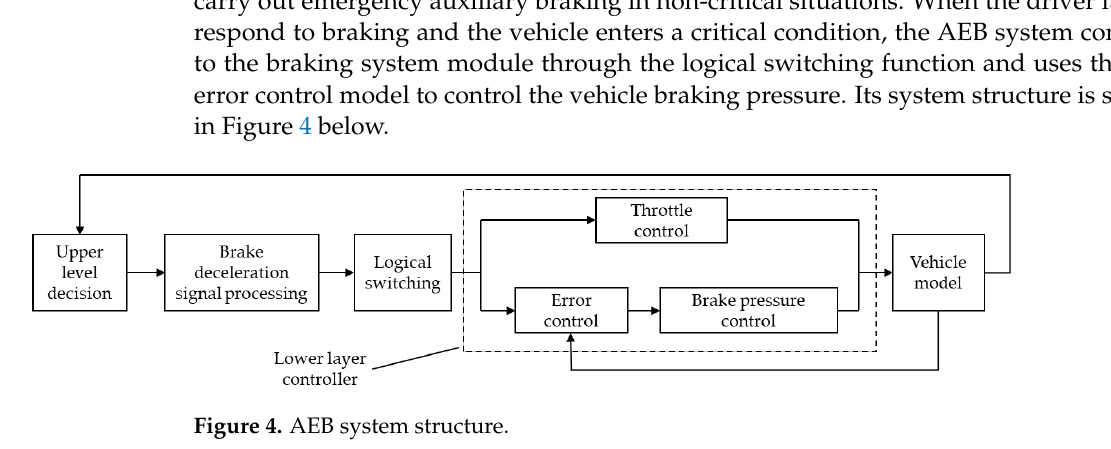
Table 2. Collision avoidance probability under dual variables of braking strength and TTC threshold.